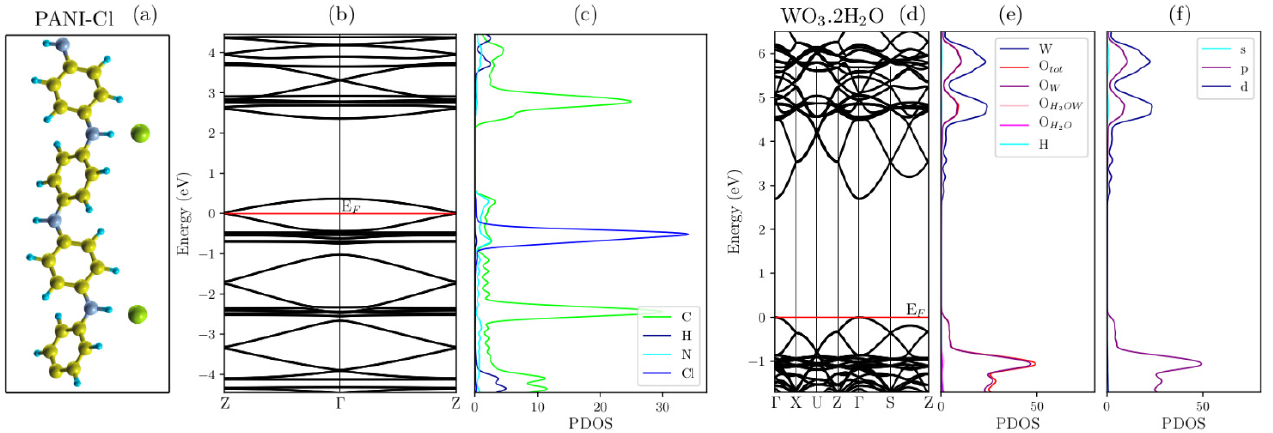
Figure 8. ( a ) Polymer system, ( b ) Its respective band structure and ( c ) PDOS for each atom. The system presented conducting behavior due to the half-filled energy bands. The PDOS confirmed the major contribution of the counter ions at the Fermi level. ( d ) Band structure, ( e ) PDOS for atom and ( f ) PDOS for orbital of the WO 3 ·2H 2 O system using the Hubbard parameter, which influenced on the gap energy of 2.60 eV (similar to that of experimental results). The valence and conduction bands presented greater contribution of the p and d -orbitals from O and W atoms, respectively.